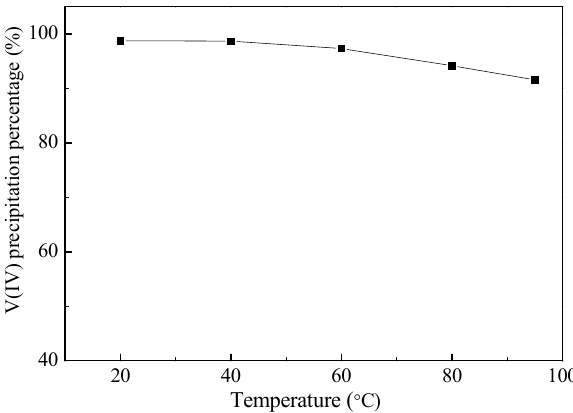
Figure 9. Effect of temperature on the vanadium precipitation percentage.